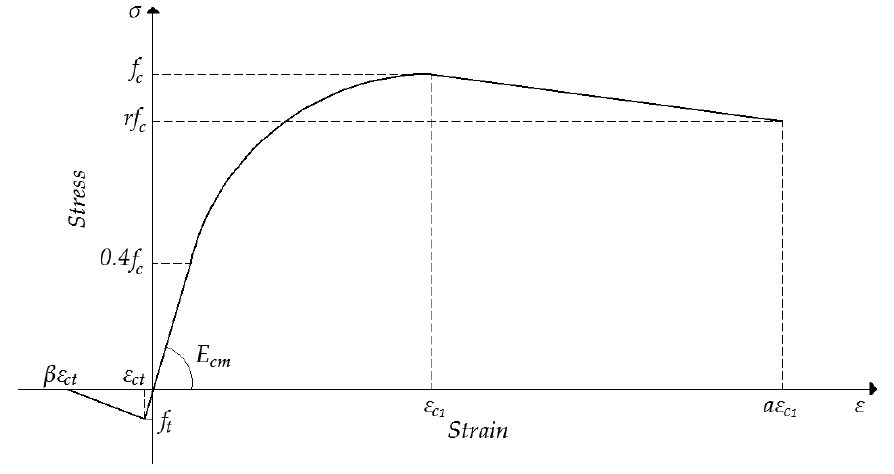
Figure 3. The concrete stress-strain model.